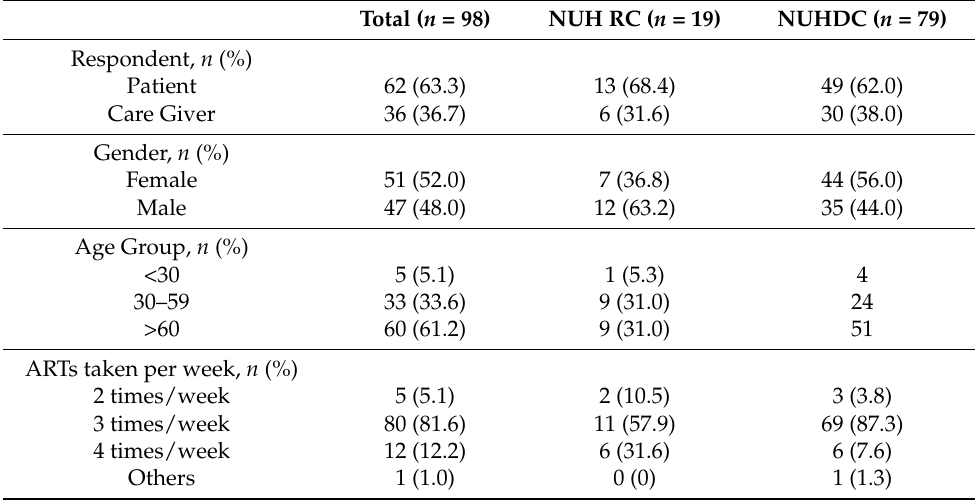
Table 1. Demographic data of survey